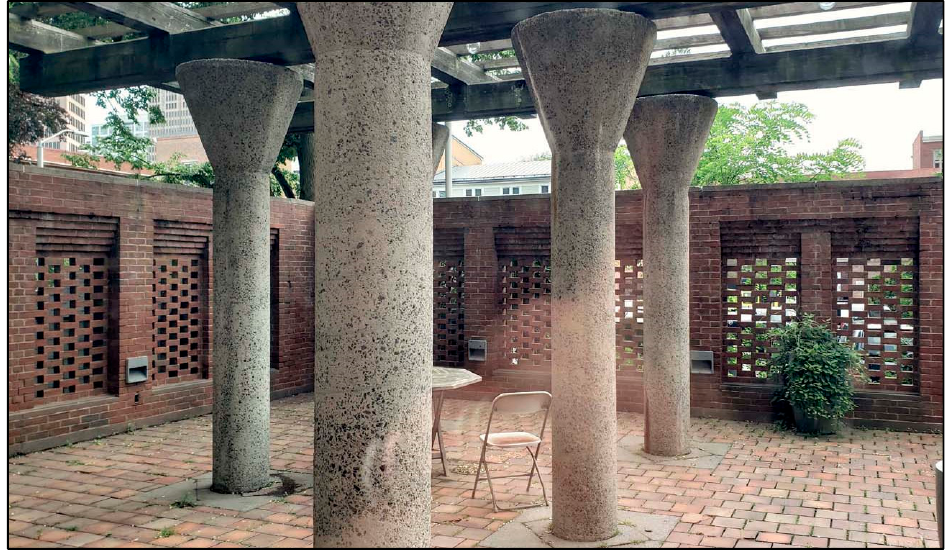
Figure 7. Slifka Center for Jewish Life at Yale, Exterior View, Rear Patio. Image Credit: © 2019 Jeremy Kargon.